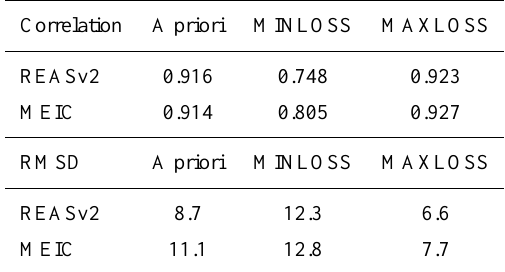
Table 3. Spatiotemporal correlations and root-mean-square